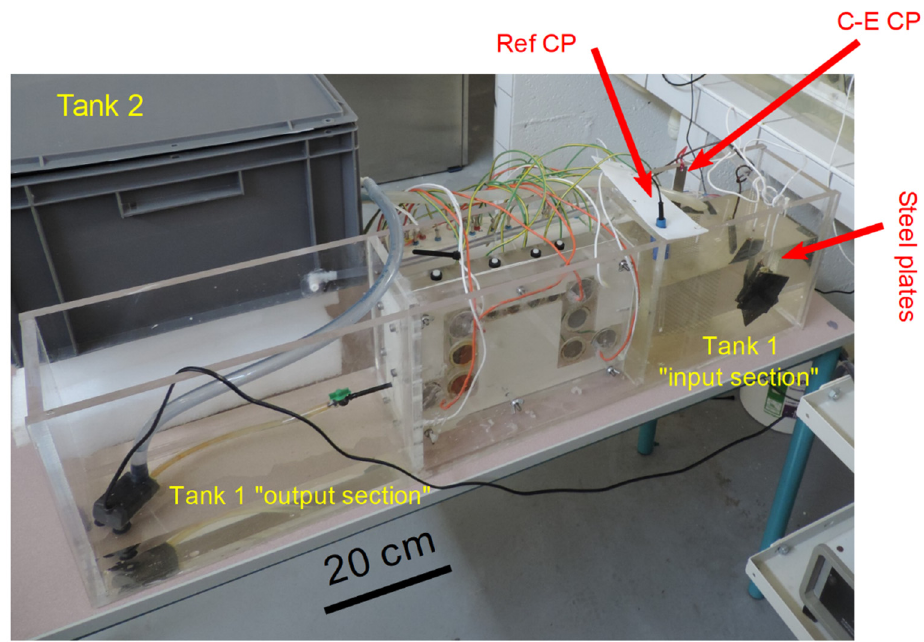
Figure 3. Image of the “real” experimental system while